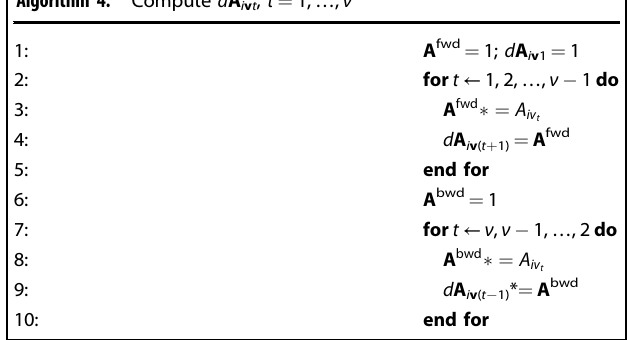
Algorithm 4. Compute d A i v t , t = 1, … , ν